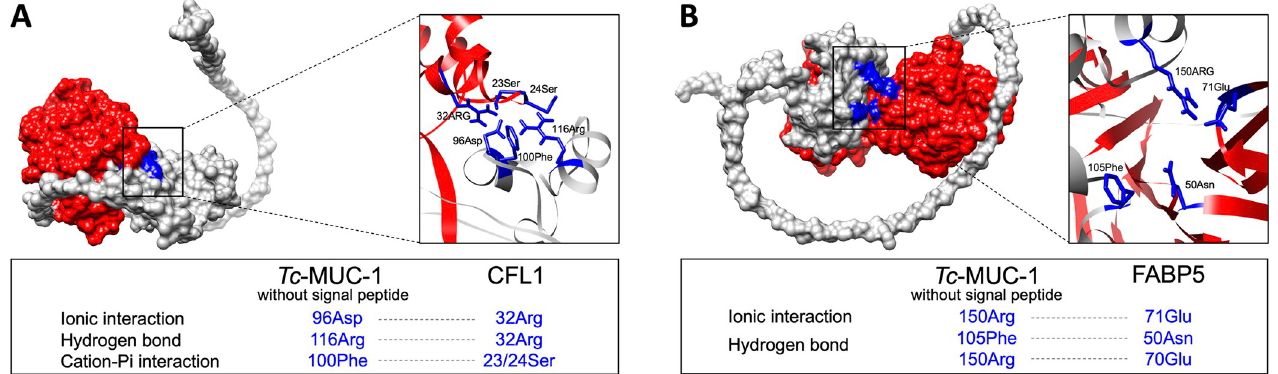
Fig 4. In silico docking of Toxocara canis mucin 1 ( Tc -MUC-1) protein and two key interacting proteins. ( A ) Protein complex predicted for Tc -MUC-1 and the cofilin 1 (CFL1) of murine RAW264.7 macrophage cells. Structures of Tc -MUC-1 and CFL1 are indicated in grey and red, respectively. ( B ) Protein complex predicted for Tc -MUC-1 and a dimer of the fatty acid binding protein 5 (FABP5) of murine RAW264.7 macrophages. Structures of Tc -MUC-1 and FABP5 are indicated in grey and red, respectively. Ionic interactions, hydrogen bonds or cation-pi binding interaction between the residues in Tc -MUC-1 (grey) and CFL1 (red) are